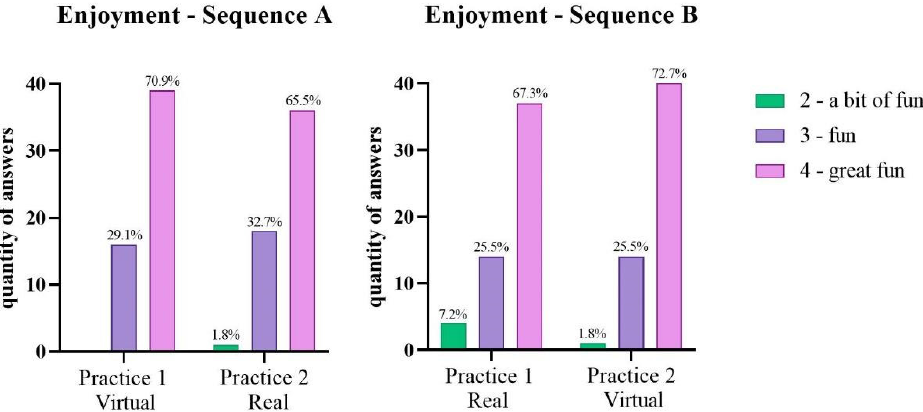
(virtual–real) and B Figure 7. Graphic representation of the frequencies of each enjoyment score in Sequences A (virtual– real) and B (real–virtual).